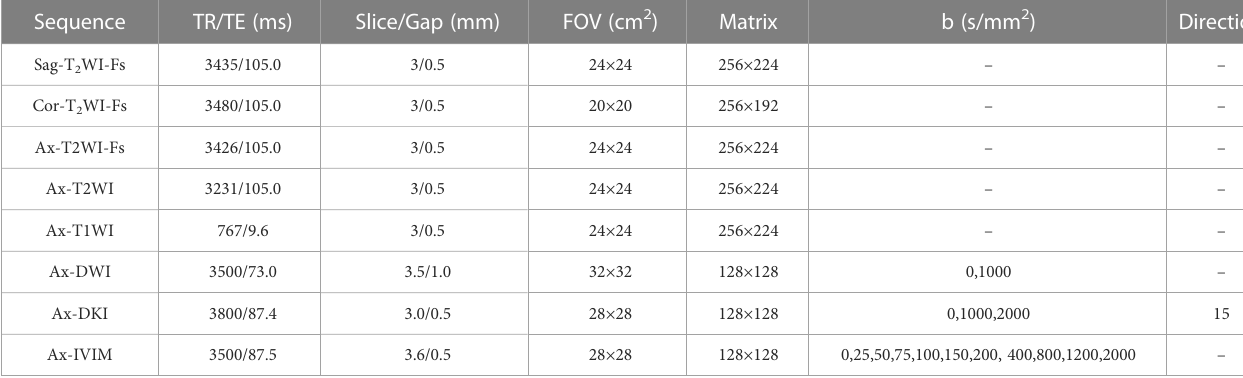
TABLE 1 Acquisition parameters of the multiparametic MRI protocol.